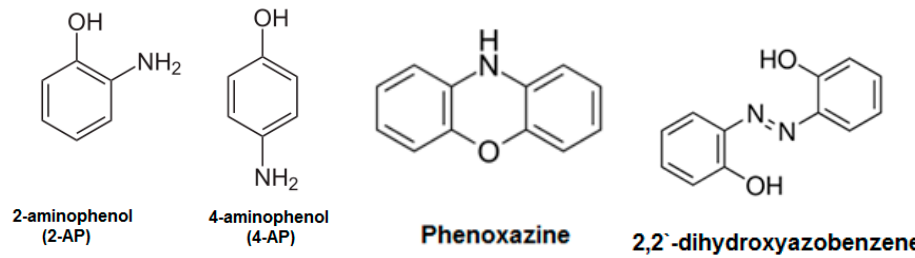
Figure 1. Molecular structure of 2-aminophenol, 4-aminophenol, phenoxazine, and 2,2 ′ -dihydroxyazobenzene.